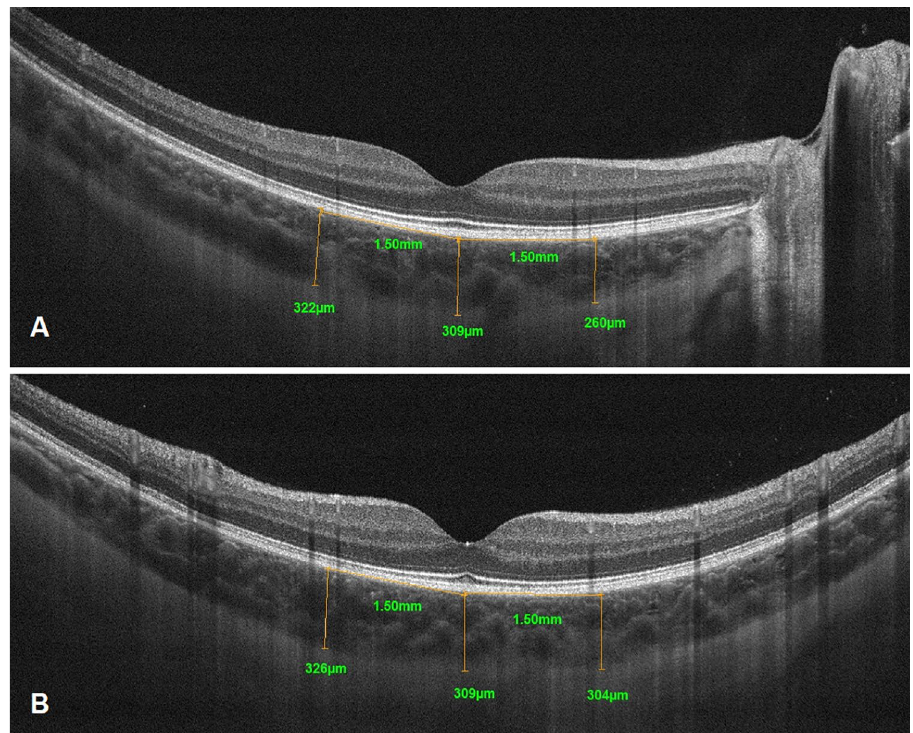
Figure 1. Representative OCT images—cross line scan horizonal ( A ) and vertical ( B ) reflecting measurement of subfoveal choroidal thickness and choroidal thickness in four macular